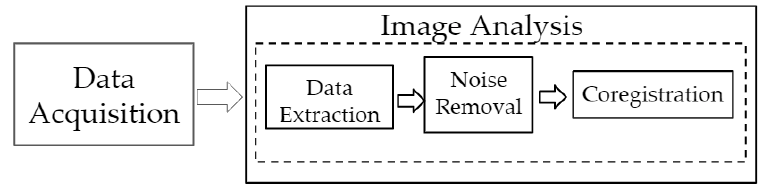
Figure 2. Flow chart of imaging analysis from the acquired data, involving data extraction, noise removal, and coregistration.